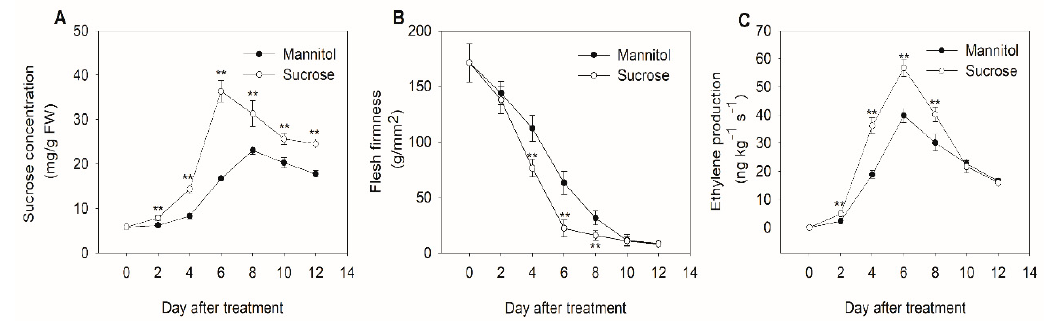
Figure 1. Influence of sucrose treatment on the ripening process of kiwifruit during storage at 20 °C. ( A ) Concentration of sucrose during kiwifruit ripening. ( B ) Changes in flesh firmness following sucrose and mannitol (control) treatment. ( C ) Ethylene production under different treatments. The data are expressed as the mean ± standard deviation. The asterisks indicate a significant difference relative to mannitol treatment.